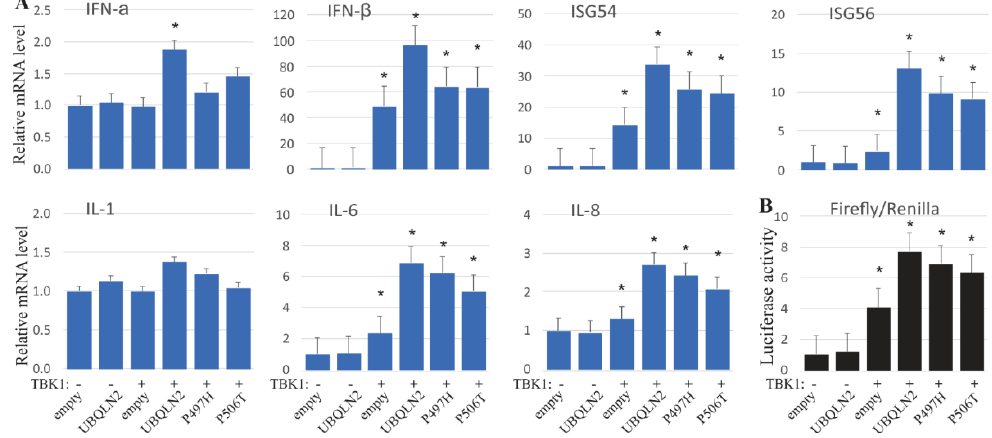
Figure 4. UBQLN2 promotes type 1 IFN production. ( A ) Quantitative PCR analysis revealed the relative levels of mRNA for IFN1 and related cytokines. HEK-293T cells. were transfected with Myc-tagged TBK1 and Flag-tagged wild-type or mutant UBQLN2. Total RNA was extracted with Trizol reagent 24 h after transfection. ( B ) Luciferase reporter assay showing the IFN- β activities. HEK-293T cells were transfected with an IFN- β (luciferase) and a Renilla-TK reporter from Addgene, along with wild-type TBK1 and UBQLN2 or their mutant forms: P497H or P506T, respectively. Assays were performed 24 h after co-transfection of TBK1 and UBQLN2. The data were calculated based on the empty vector, and are reported as the mean ± standard deviation (n = 3). * p < 0.05.